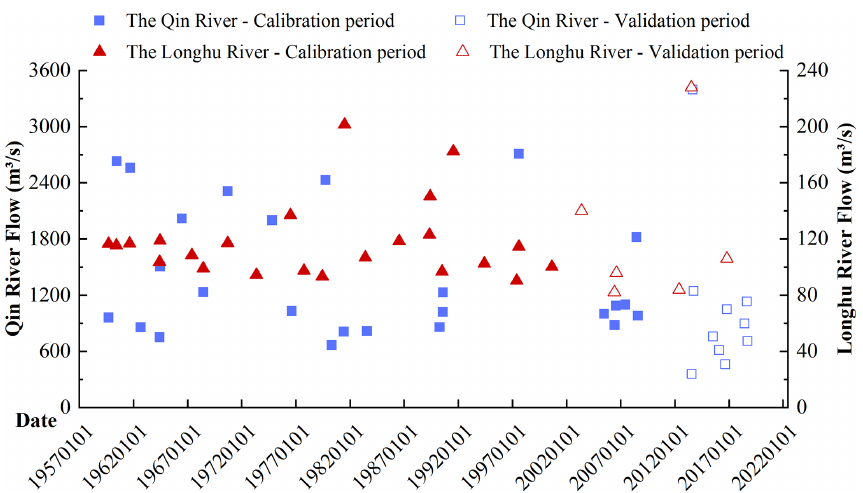
Figure 6. Statistics of flow events used for model calibration and validation.